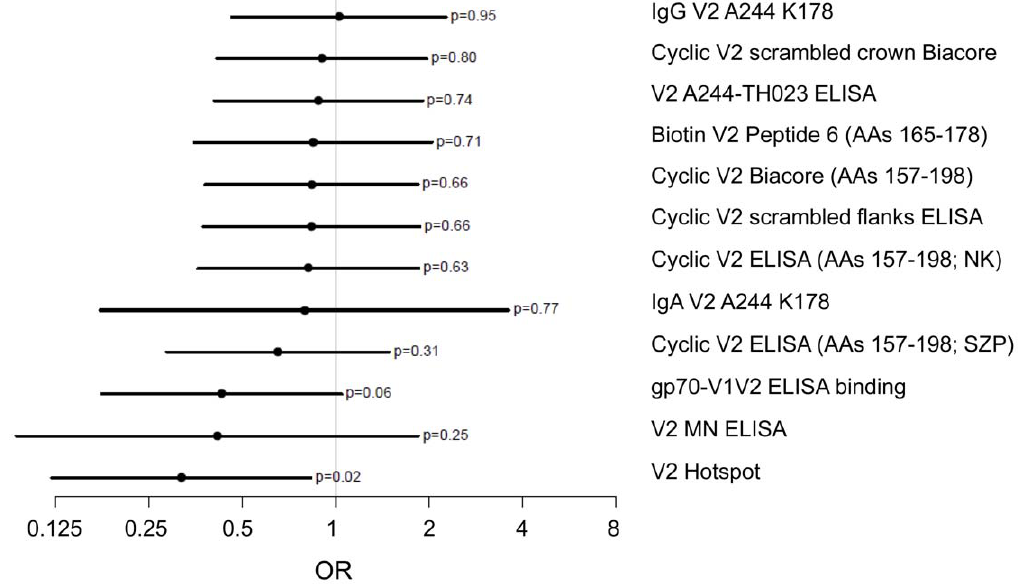
Figure 7. Estimated odds ratios (OR) and 95% confidence intervals for each of the V2 assays. Data are derived from the categorical analyses shown in Table 1 . Estimated ORs compare subgroups defined by High vs. Low responses except for comparisons for analyses of IgA V2 A244 K178 and V2 MN which compare Positive vs. Negative responses. For evaluation of biotinylated V2 Peptide 6, comparison is between High and Negative responses.